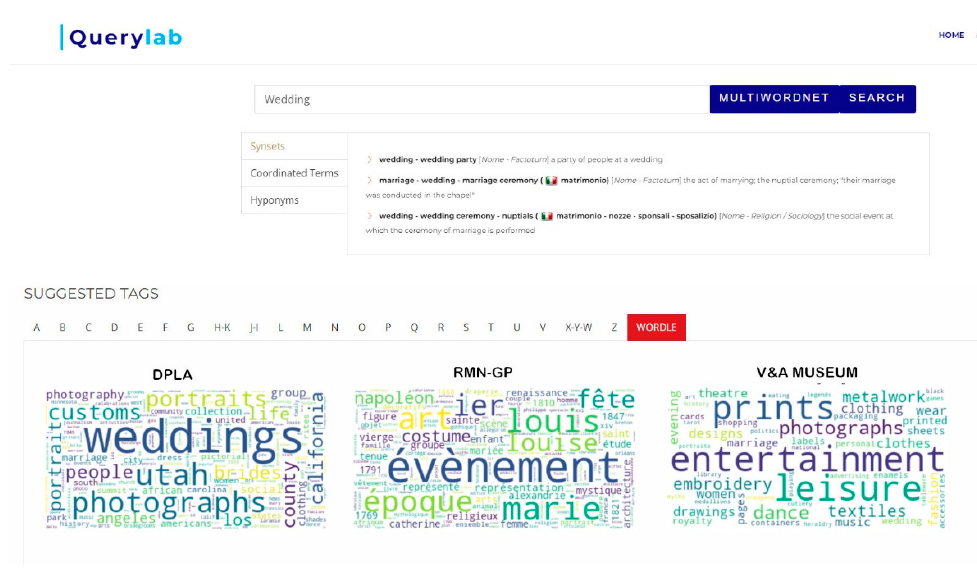
Figure 10. Tag word cloud for Digital Public Library of America (DPLA, USA), Réunion des Musée Nationaux (RMN, France) and Victoria&Albert Museum (England), respectively, for the query ‘wedding’ (‘mariage’ in French).